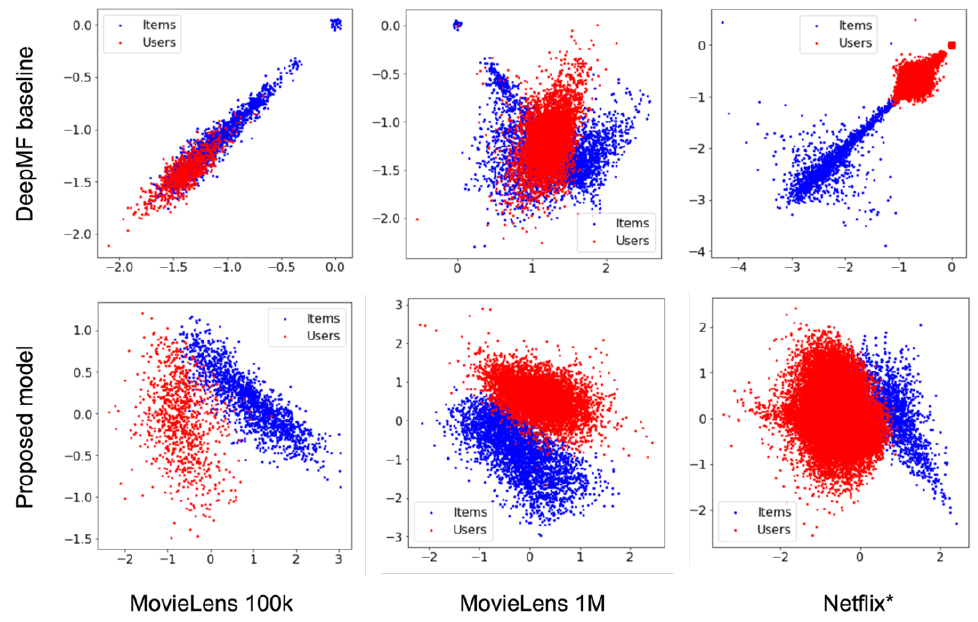
Figure 5. Embedding visualizations of users (red points) and items (blue points) for datasets in Table 1 when the DeepMF baseline is applied (top graphs) versus the proposed variational Euclidean method (bottom graphs).